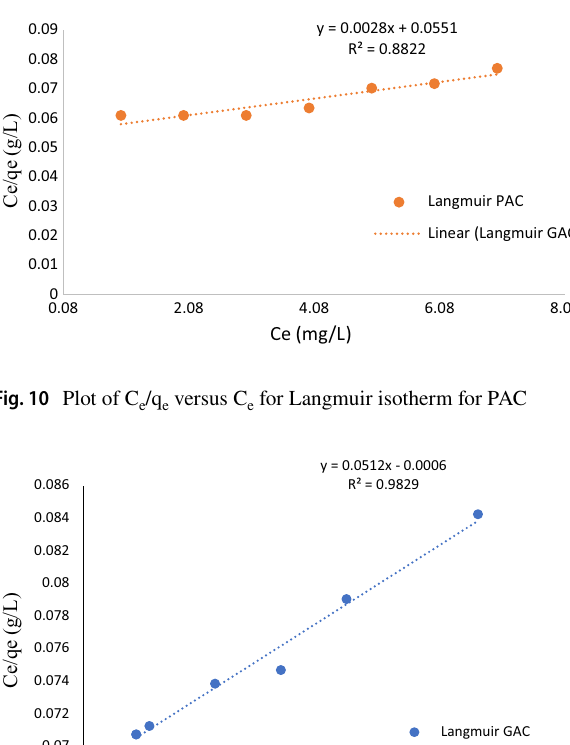
Fig. 9 Hg(II) removal (%) versus dose of powdered activated car- bon (PAC) and granular activated carbon (GAC) at contact time 30 min,pH = 6.05, 40.41 mg/L Hg(II) ions